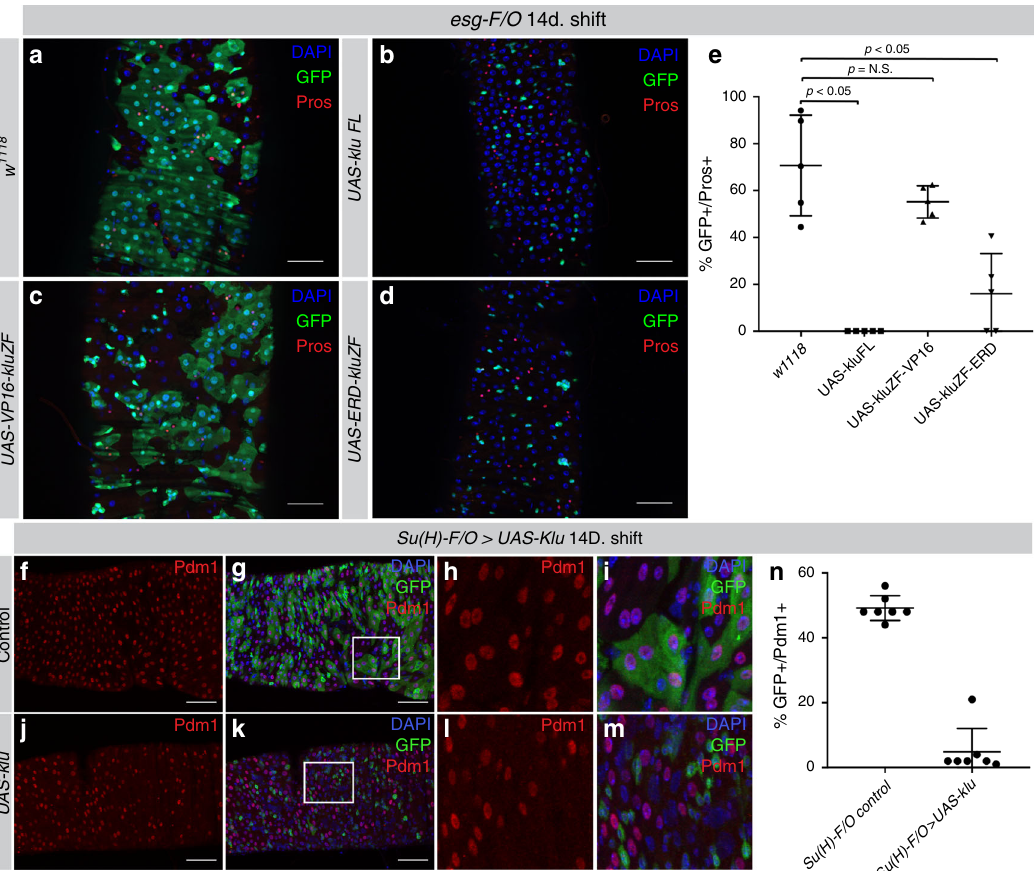
Fig. 3 Klu overactivation results in a loss of Delta-Notch signaling and ISC differentiation. a – d Clonal expression of different Klu isoforms using the esg- Gal4 -driven FlipOut ( esg-F/O ) system to generate ISC clones. a Control esg-FO clones grow to occupy most of the posterior midgut 2 weeks after